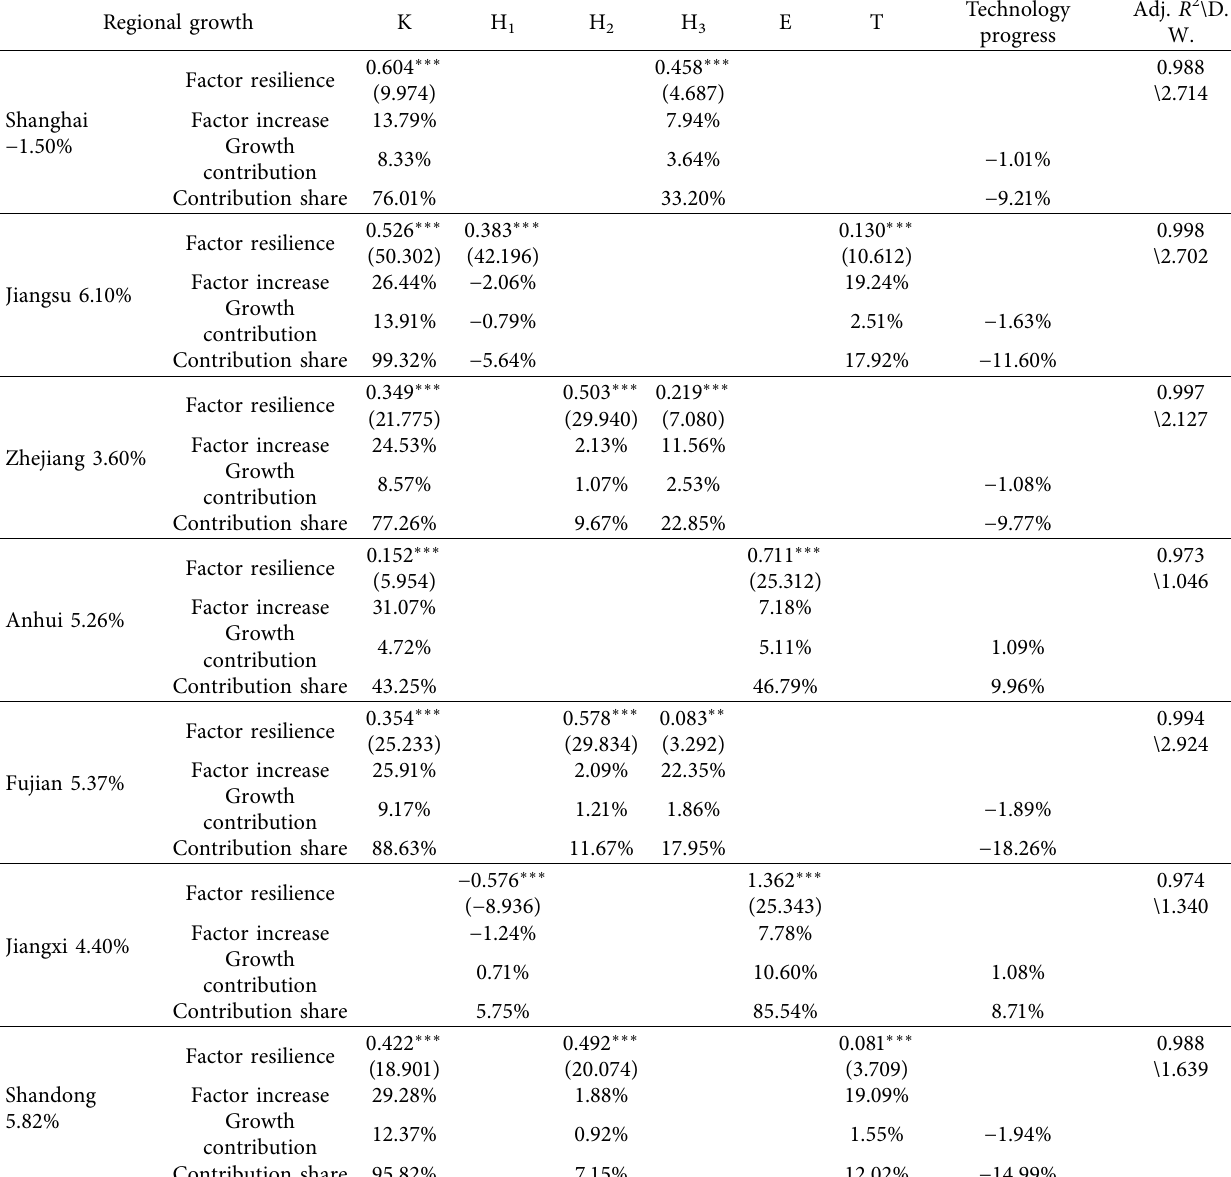
Table 3: Output elasticity of tertiary